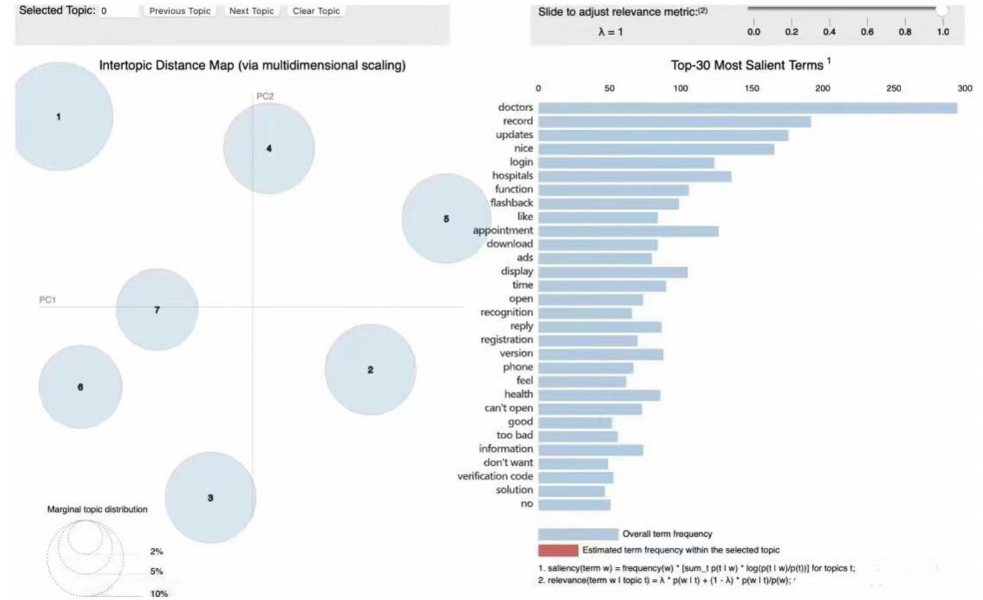
Figure 5. Clustering visualization results of online review topics of mobile medical apps. The circle on the left corresponds to the seven themes, and the words on the right correspond to the topics. The distance between different circles indicates the closeness of different themes. If the circles overlap, there is a crossover between the features of different